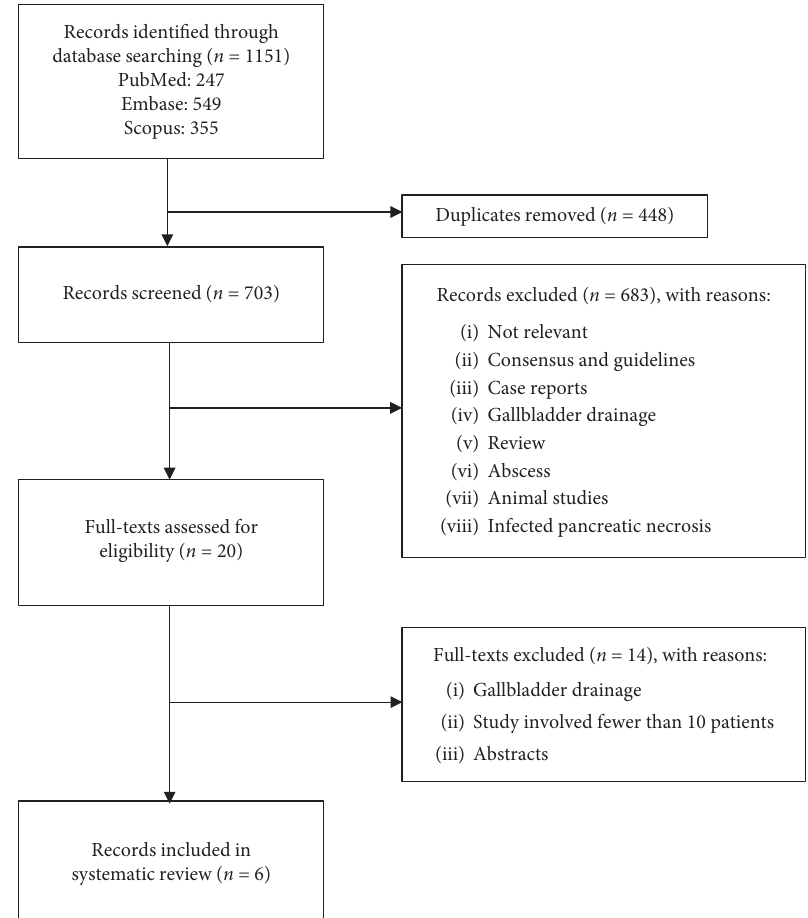
Figure 1: Flow diagram of literature search and